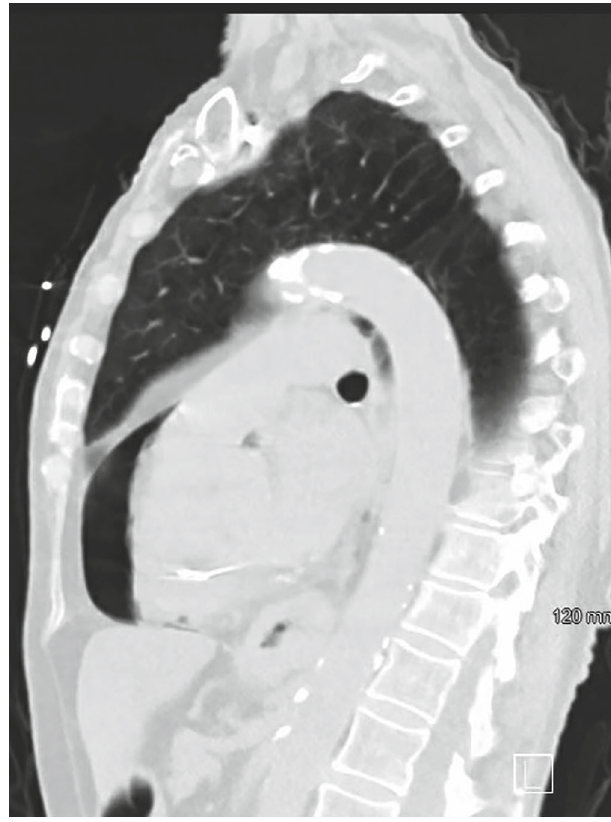
Figure 4: CT chest sagittal view demonstrating